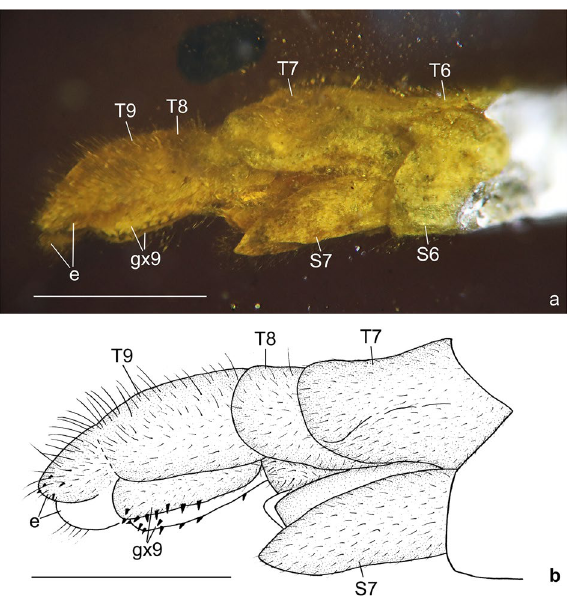
Figure 3. Calobabinskaia xiai sp. nov., holotype female. ( a ) photograph of genitalia, lateral view; ( b ) drawing of genitalia, lateral view (drawn by XML). Scale bar = 1.0